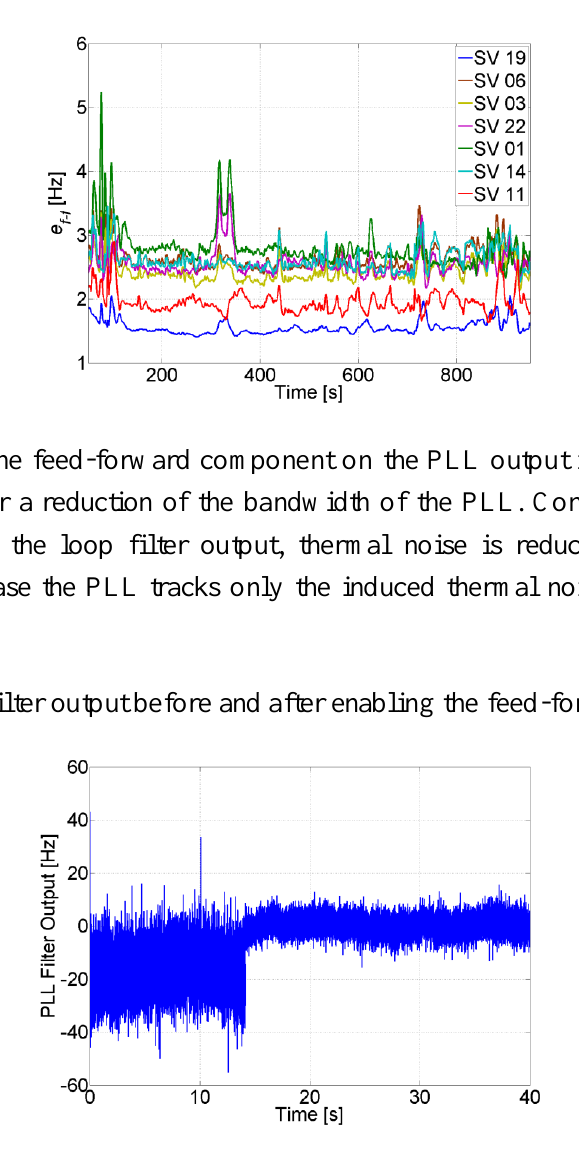
Figure 9. Feed-forward frequency uncertainty in open-sky conditions.